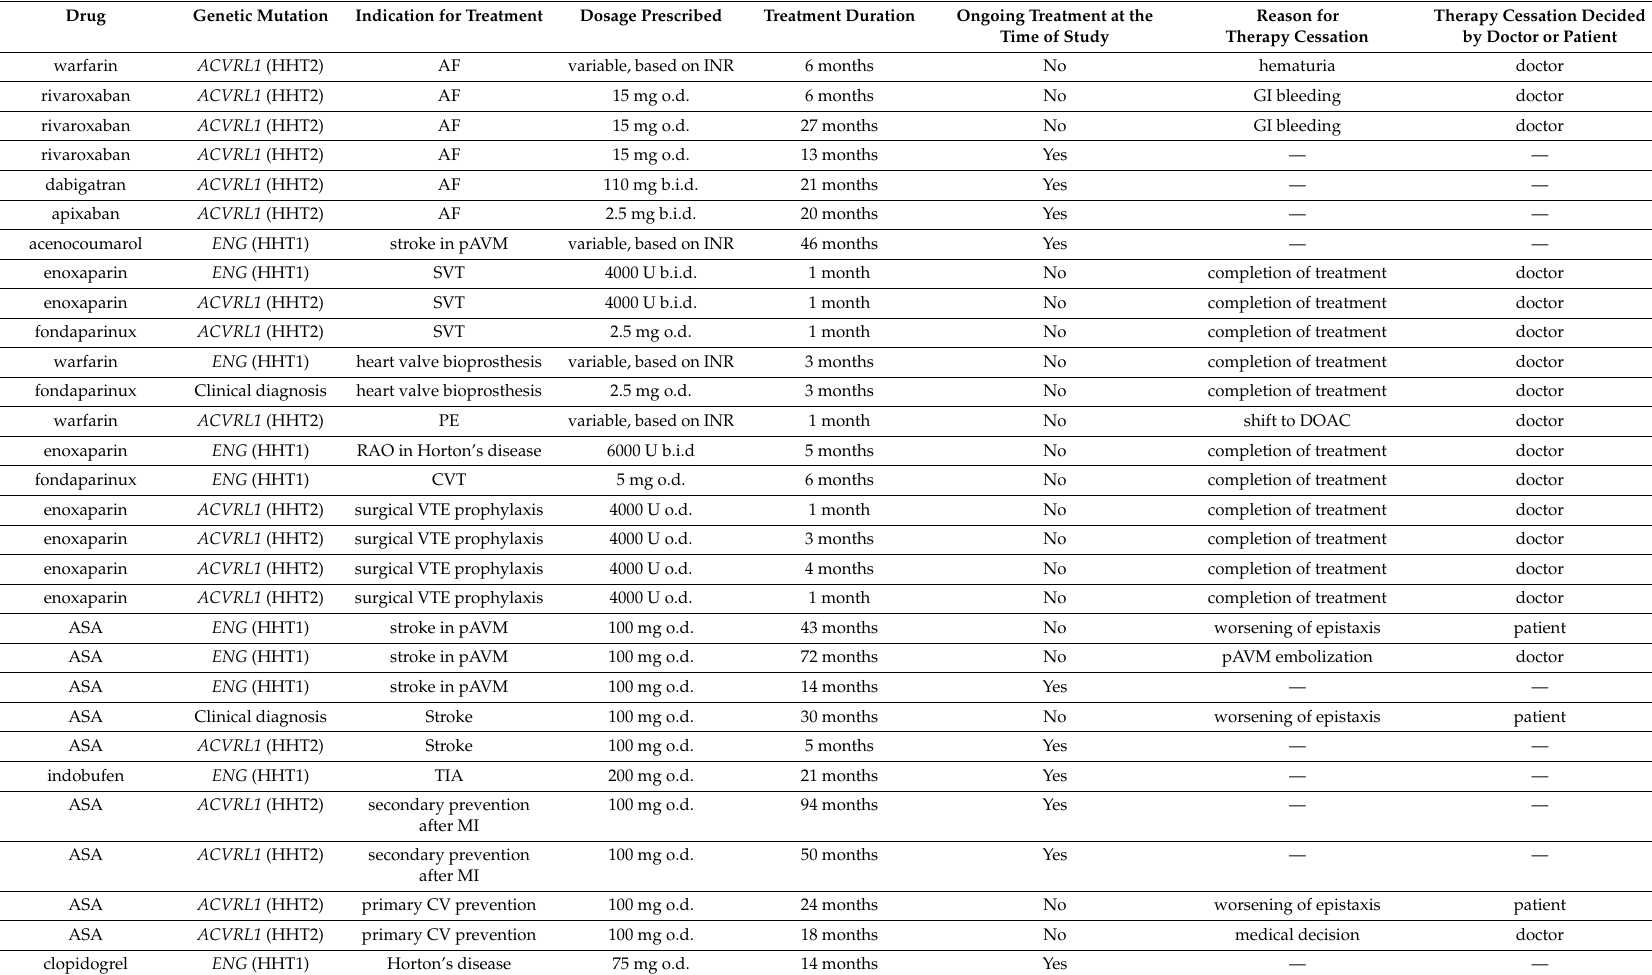
Table 3. Dosage, duration of treatment, compliance to AT, and reasons for therapy